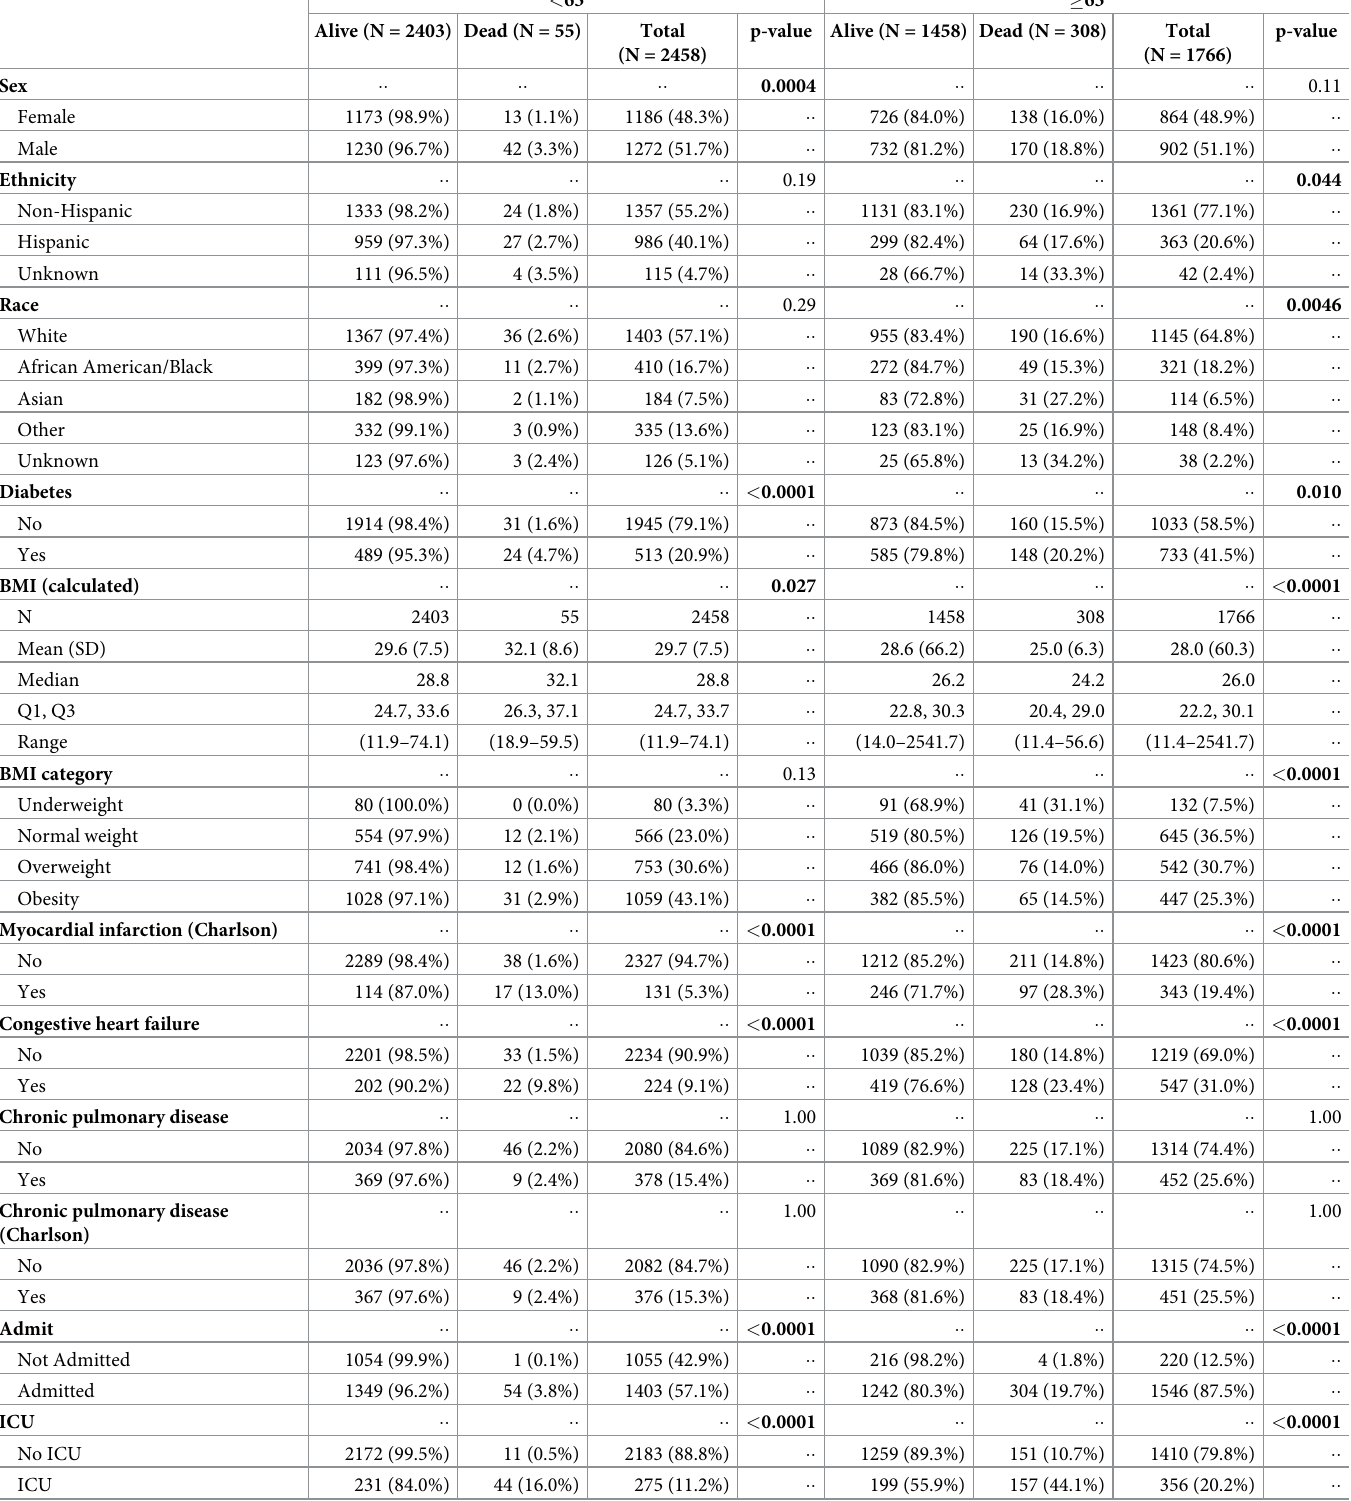
Table 1. Characteristics of patients with objective BMI data, stratified by